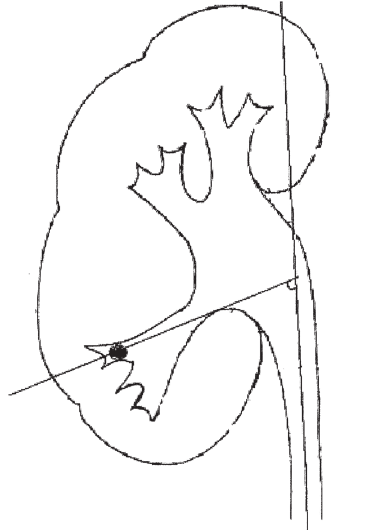
Figure 2 - Infundibulopelvic angle described by Sampaio et al. The angle formed by the central axis of the infundibulum containing the calculi and another axis connecting the central points of the ureter at the lower pole and ureteropelvic